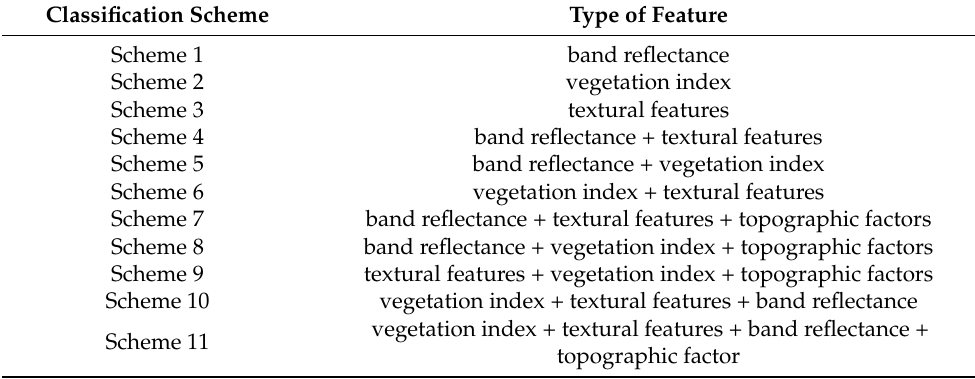
Table 6. Classification